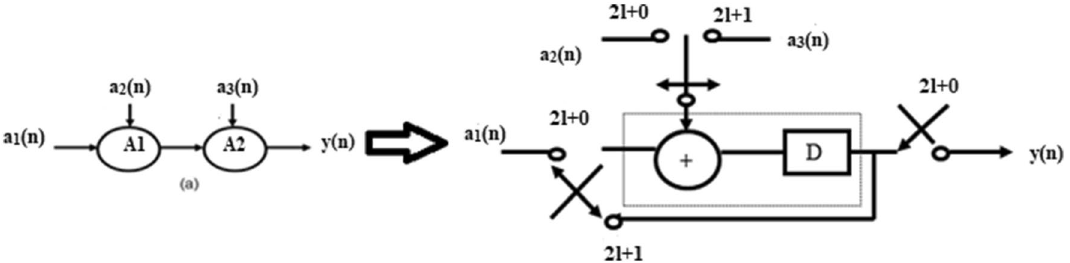
Figure 6. Folded adder.